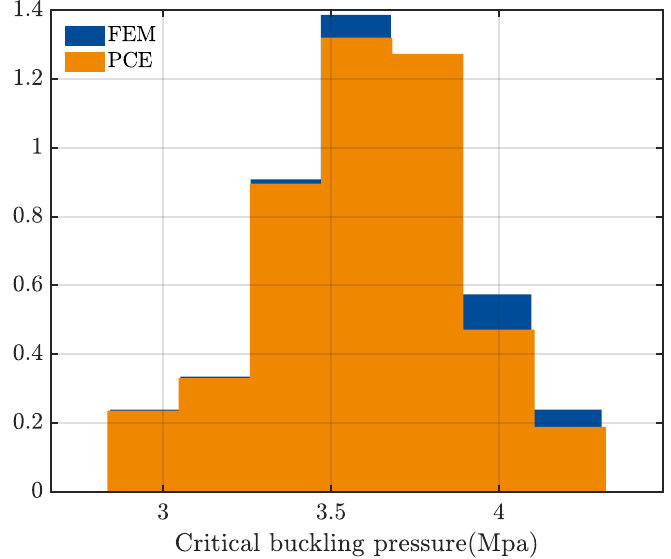
Figure 7. Normalized histogram of critical buckling pressure obtained using the finite element method Y FEM and PCE prediction Y PCE .